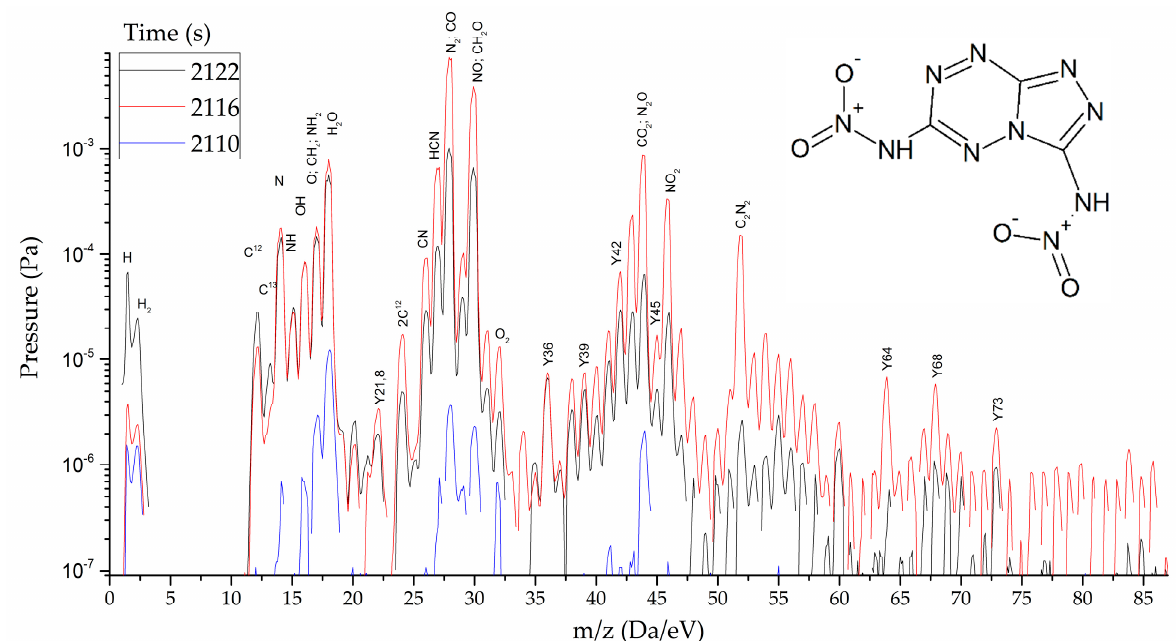
Figure 10. Mass spectra of gaseous products of DNTT reactions at the peak of decomposition at heating rates from 1.5 to 2000 s − 1 .